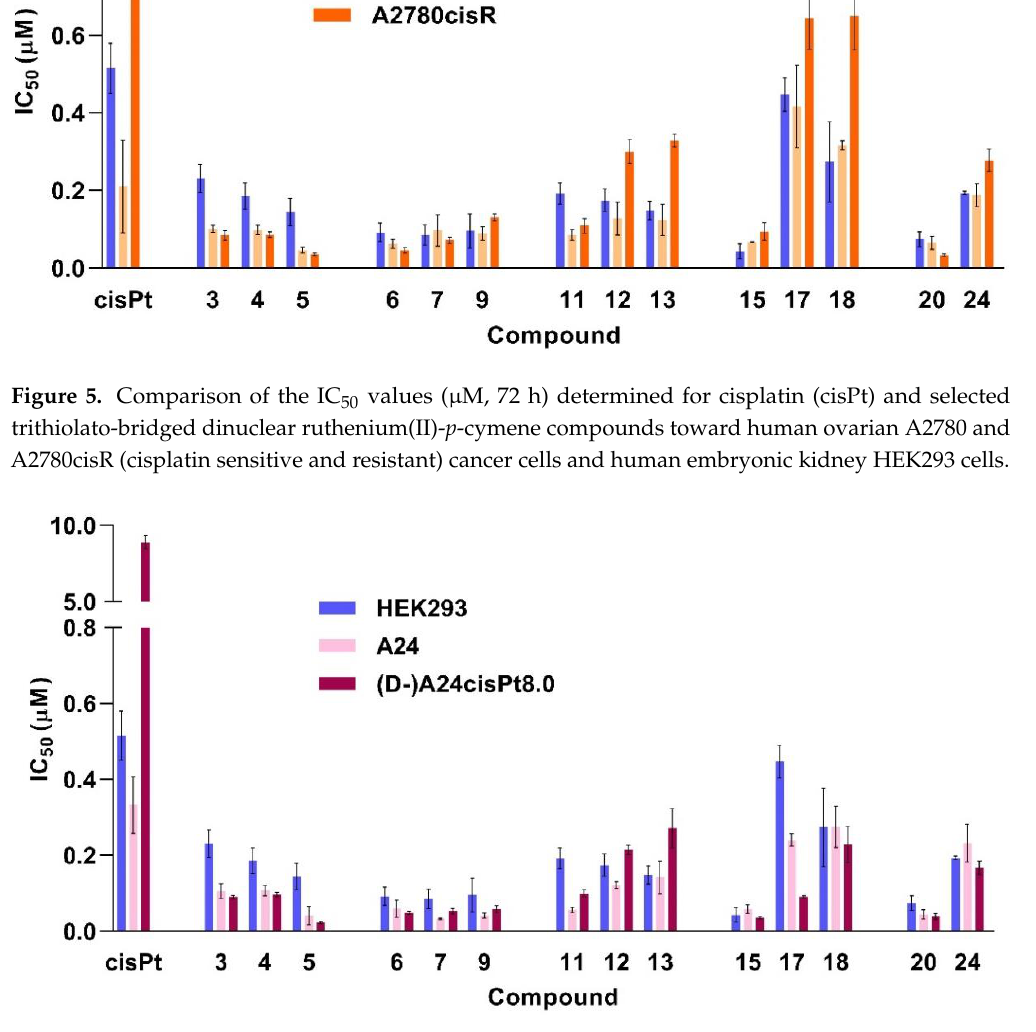
Figure 6. Comparison of the IC 50 values ( µ M, 72 h) determined for cisplatin (cisPt) and selected trithiolato-bridged dinuclear ruthenium(II)- p -cymene compounds toward human lung adenocarcinoma wild type A24 and de-induced (D-)A24cisPt8.0 subline cells and human embryonic kidney HEK293 cells.